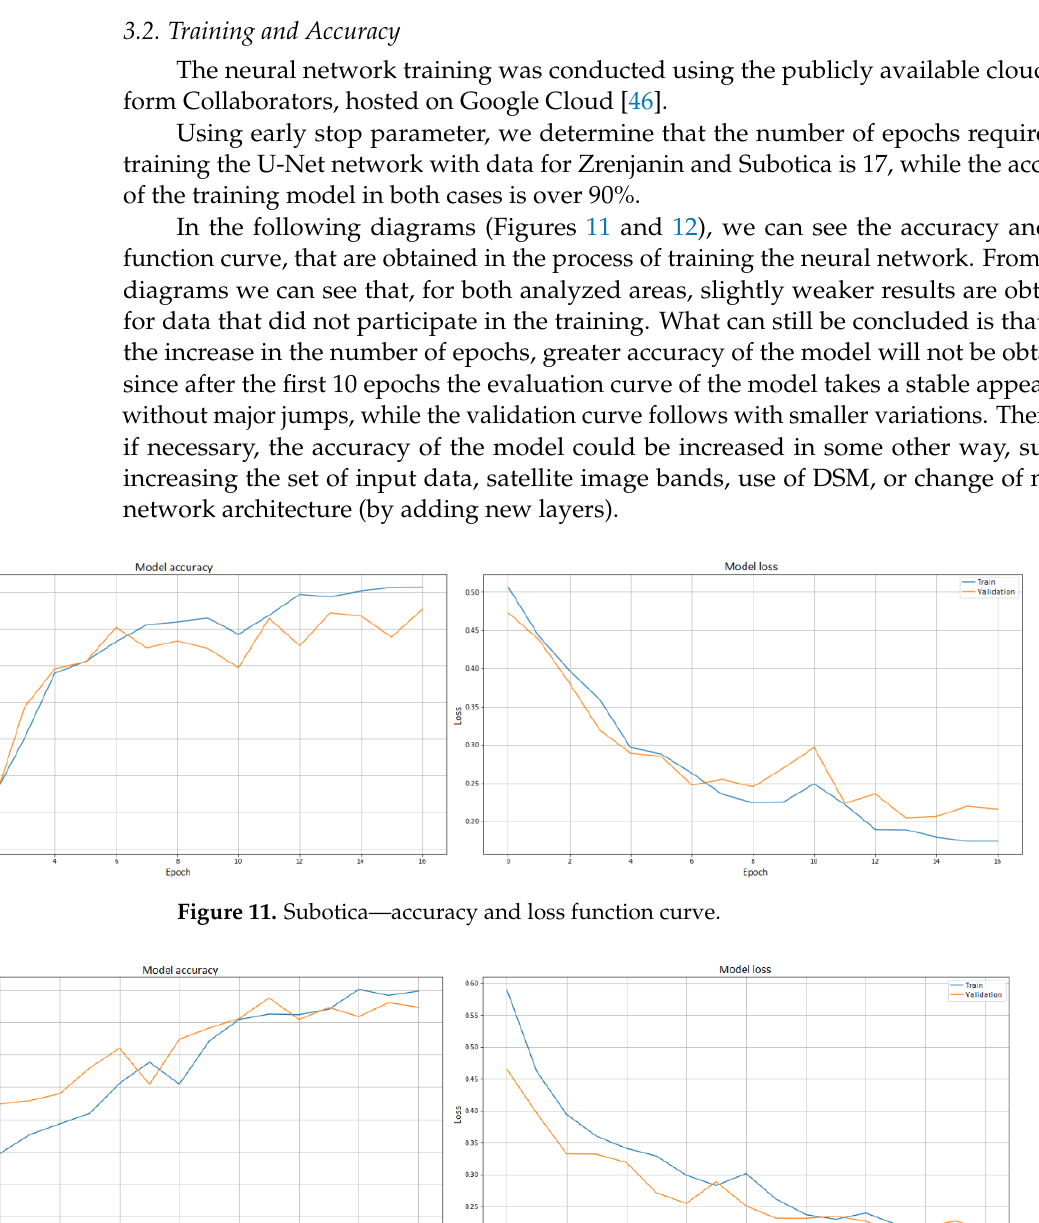
Table 2. Building identification results in test area.